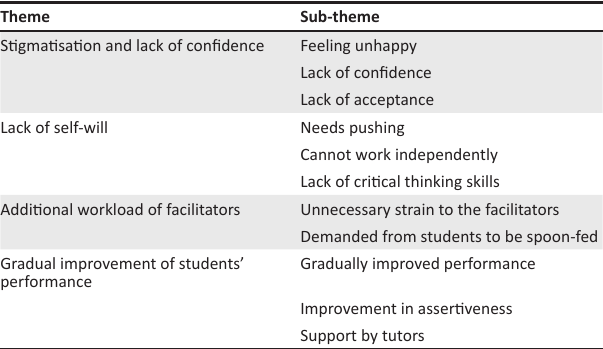
TABLE 1: Themes and sub-themes. Theme